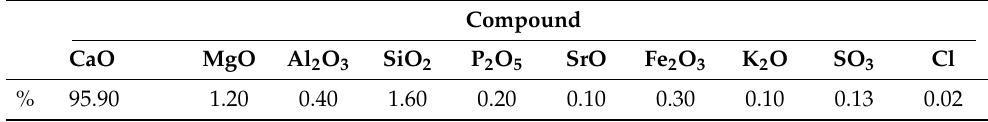
Table 3. X-ray fluorescence (XRF) analysis of Austin chalk.